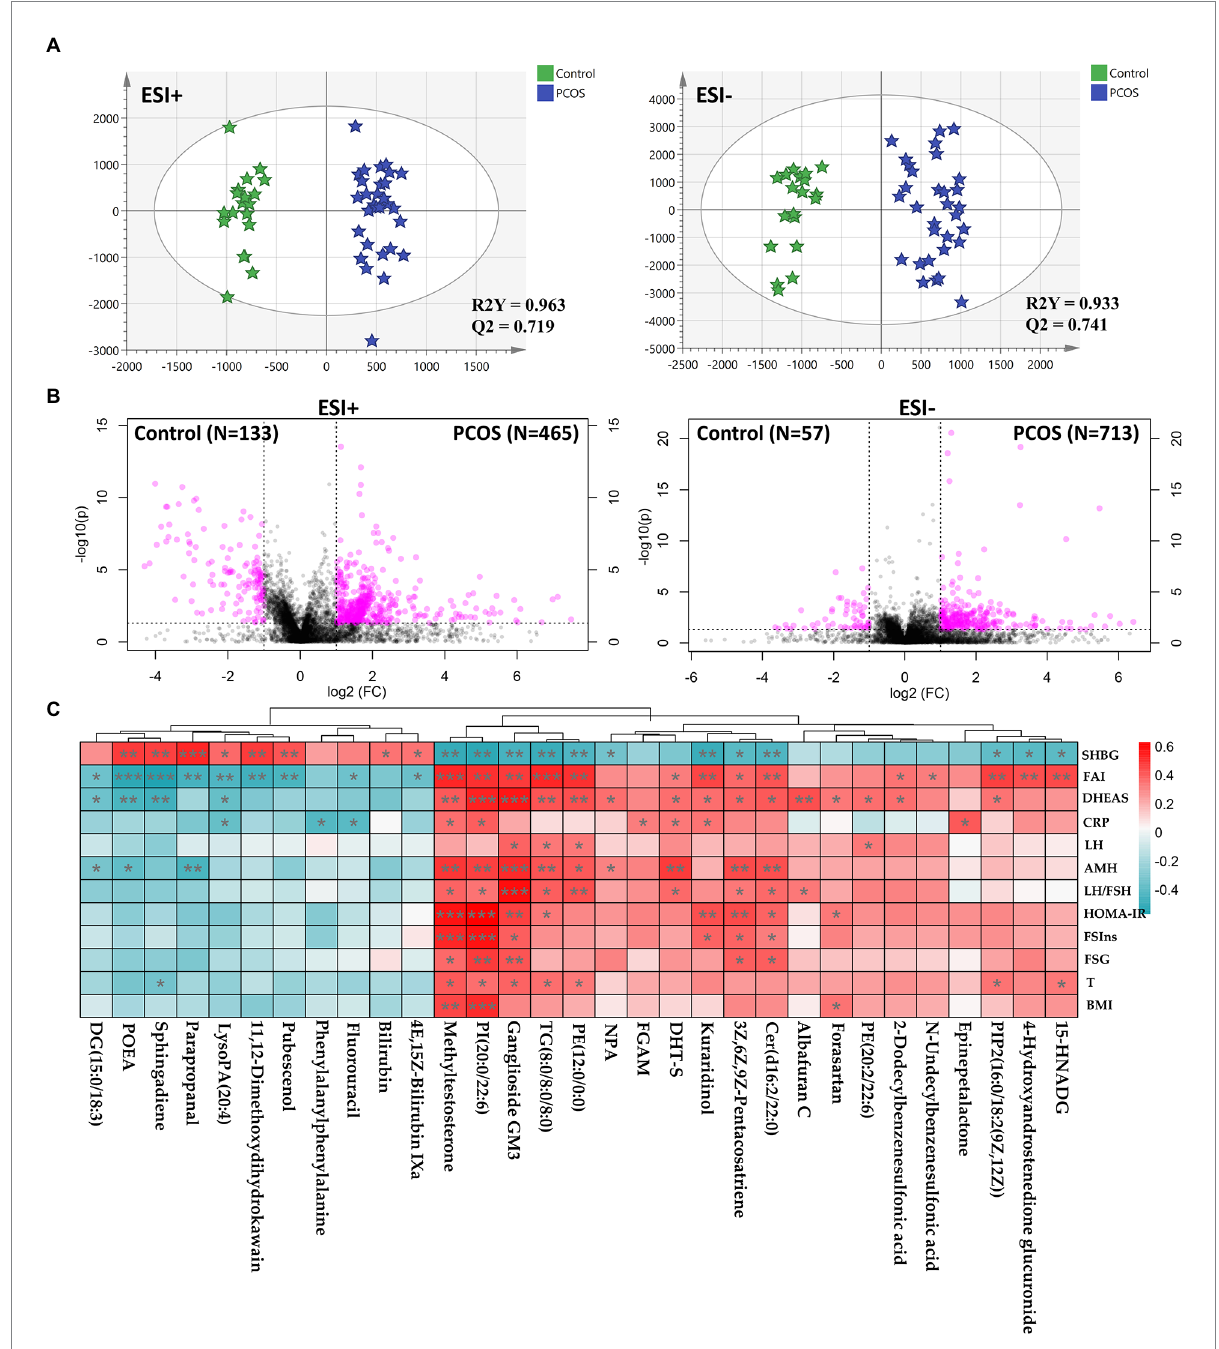
FIGURE 3 Serum metabolomics profiling underlying PCOS. (A) Orthogonal partial least-squares discrimination analysis (OPLS-DA) score plots constructed using untargeted metabolomics data. (B) Volcano plots used to screen differential compounds between PCOS and healthy subjects. (C) Correlation heatmap analysis between differential metabolites and clinical indicators in PCOS. DG, diacylglycerol; POEA, palmitoleoyl ethanolamd; LysoPA, lysophosphatidic acid; DHT-S, 5 α -Dihydrotestosterone sulfate; FGAM, 5 ′ -Phosphoribosyl-N-formylglycinamidine; Cer, ceramide; PI, phosphatidylinositols; TG, triglyceride; PE, phosphatidylethanolamine; PIP2, phosphatidylinositol diphosphate; 15-HNADG, 15-Hydroxynorandrostene-3,17-dione glucuronide; NPA, N-[2-(3,4-dimethoxyphenyl)ethyl]-3-[4-methoxy-3-(sulfooxy)phenyl]propanimidic acid; SHBG, sex hormone binding globulin; LH, luteinizing hormone; LH/FSH, the ratio of LH to follicle-stimulating hormone (FSH); AMH, Anti-Mullerian hormone; T, total testosterone; FSIns, fasting serum insulin; HOMA-IR, homeostasis model assessment of insulin resistance; BMI, body mass index; FSG, fasting serum glucose; CRP, C-reactive protein; DHEAS, dehydroepiandrosterone sulfate; and FAI, free androgen index. Correlation coefficient between two parameters was calculated based on Pearson’s approach. * p < 0.05, ** p < 0.01, and *** p <